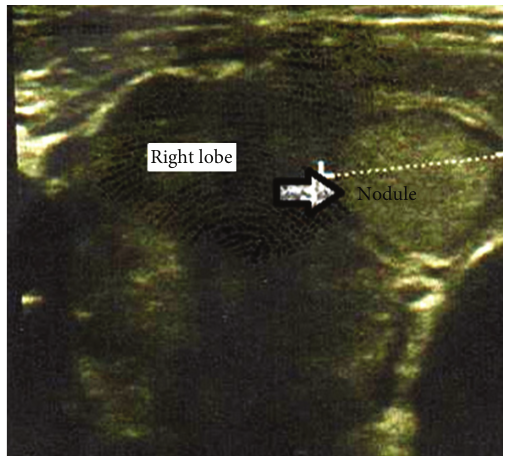
F 1: Ultrasonography of thyroid gland showing heterogeneous parenchyma and the solitary nodule in right lobe.